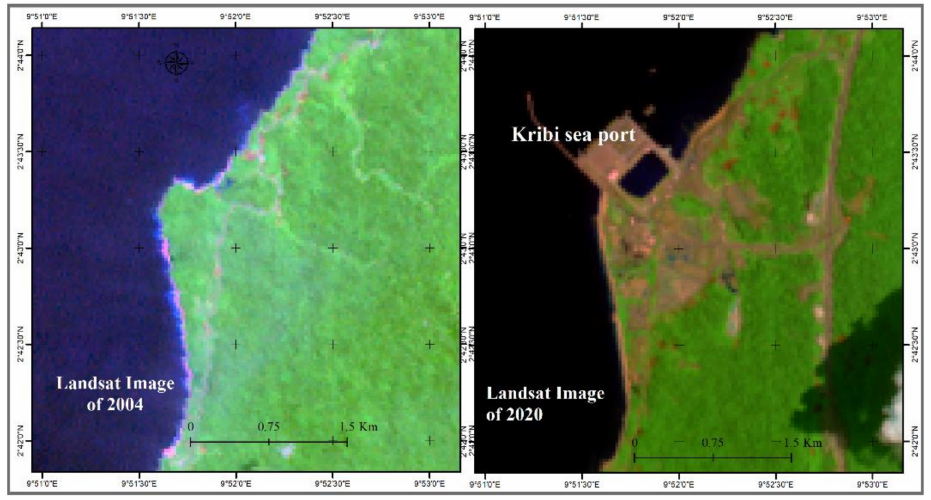
Figure 22. Landsat satellite images from 2004 on the left and from 2020 on the right show the deforestation induced by the construction of the PAK on the Kribi coastal